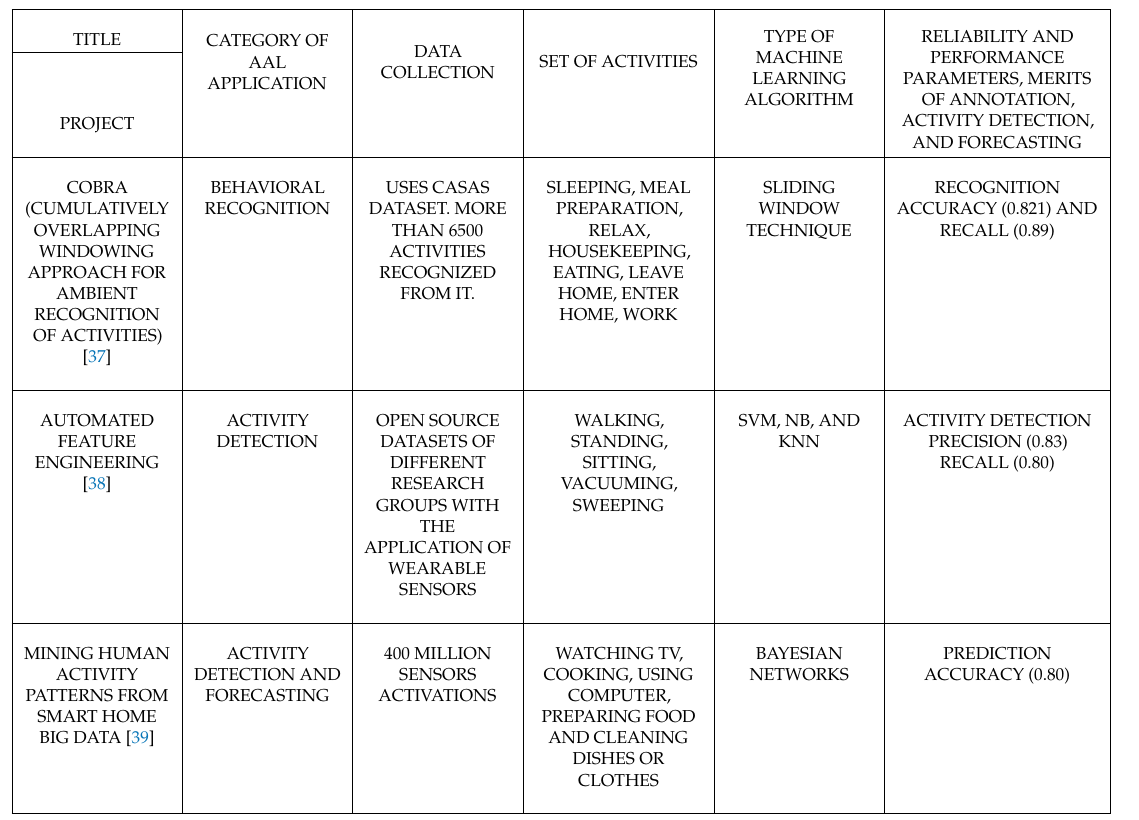
Table 6. Comparative overview of present work with existing ADLs monitoring and forecasting